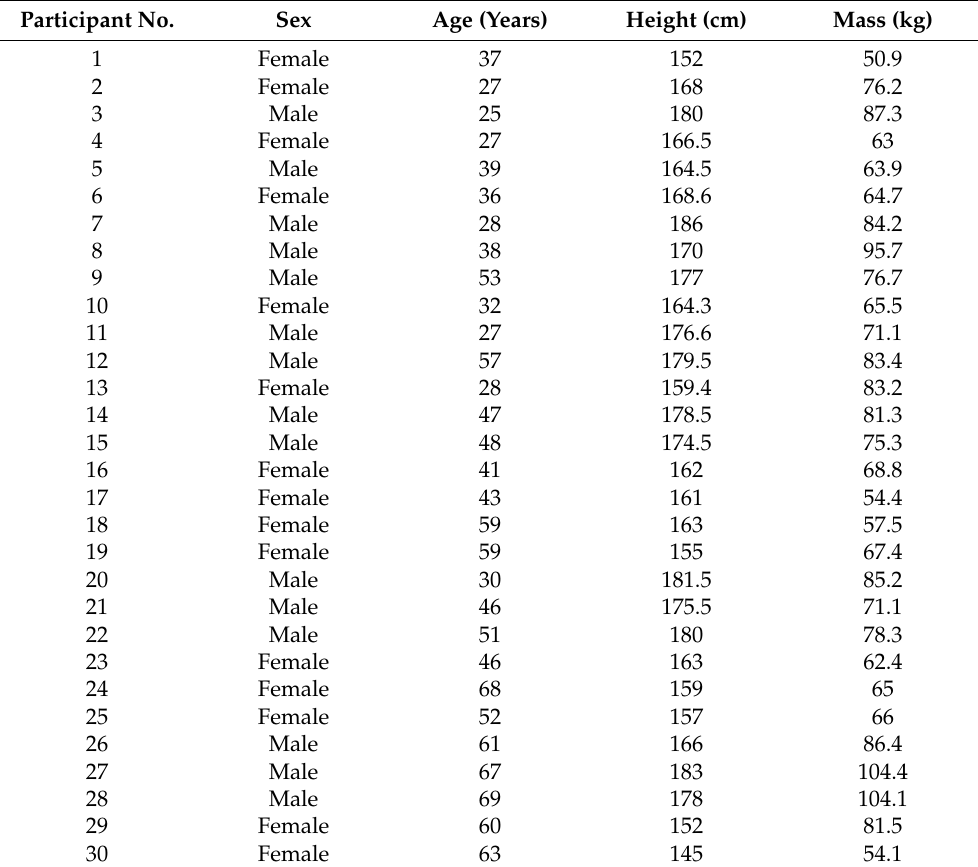
Table 1. Participant